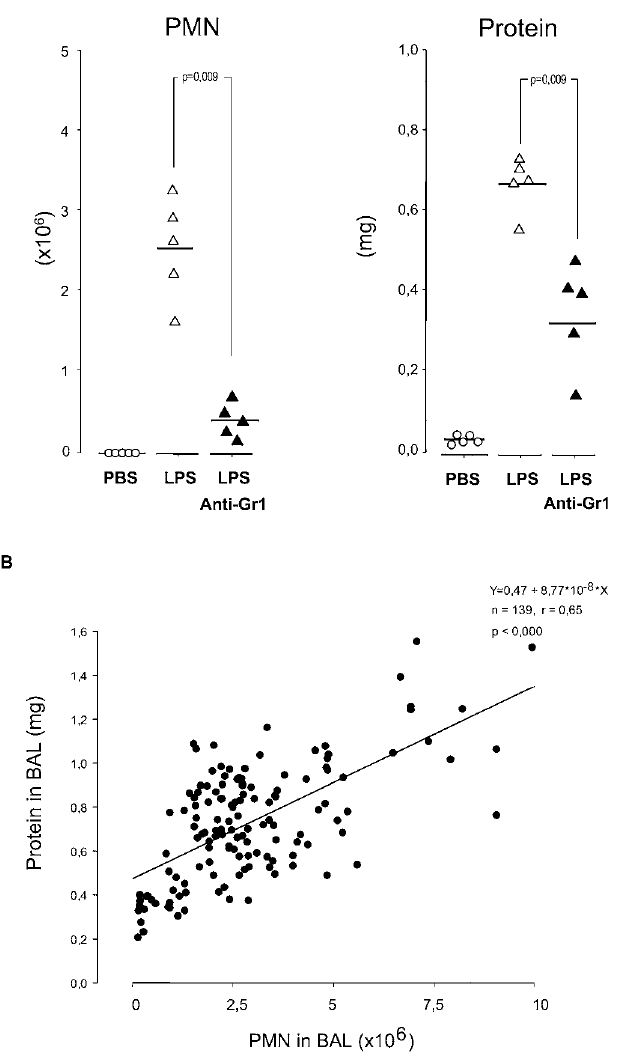
Figure 3. Role of PMNs in the Pathogenesis of LPS-Induced Lung Injury (A) Depletion of granulocytes attenuates the endotoxin induced rise in alveolocapillary permeability. Pretreatment of mice with anti-Gr-1 was followed by a significant decrease in the number of granulocytes (left graph) and a significant reduction of the total amount of protein (right graph) recovered by BAL 48 h after IT LPS injection. (B) The more granulocytes immigrated into the alveolar spaces, the higher the alveolocapillary permeability rose. Bivariate analysis according to Pearson revealed a statistically significant correlation ( p , 0,001) between the number of PMNs and the amount of protein in the BAL fluid 48 h after IT LPS injection, suggesting that inflammatory lung injury after IT injection of LPS is mostly mediated by